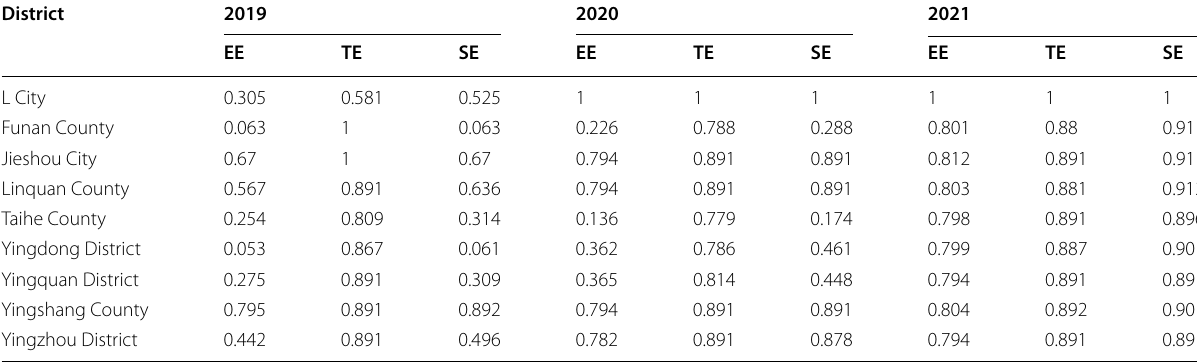
Note: *** and ** indicate significant correlation at the 1% and 5% levels (two-tailed), respectively Table 4 Allocation efficiency of government service resources in L city and counties under its jurisdiction, 2019‑2021